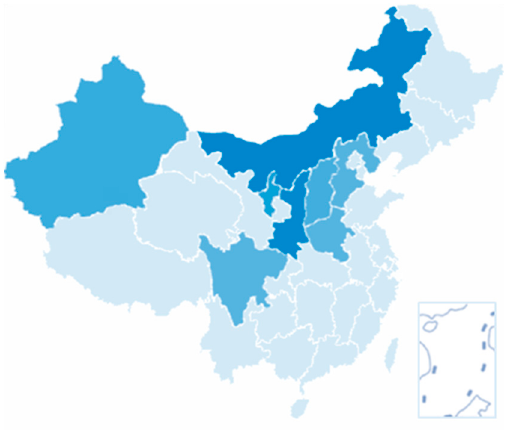
Figure 7. Total environmental impact of natural gas liquefaction in China.